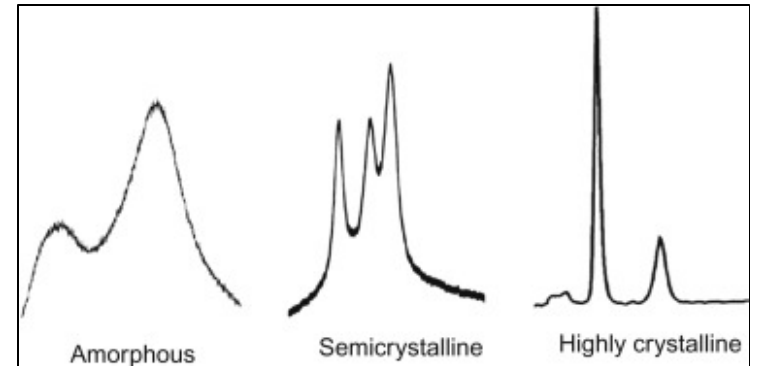
Figure 15. XRD data of a mixed ‐ matrix membrane of polyethersulfone membrane with aluminosilicate particles [66].